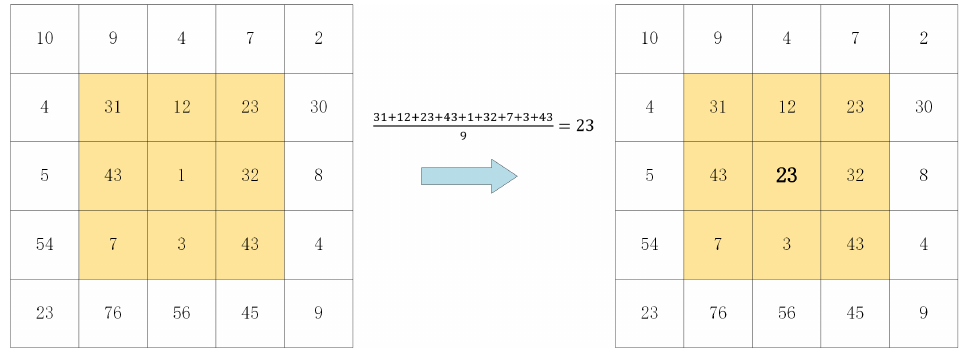
Figure 4. Median filtering sliding window.